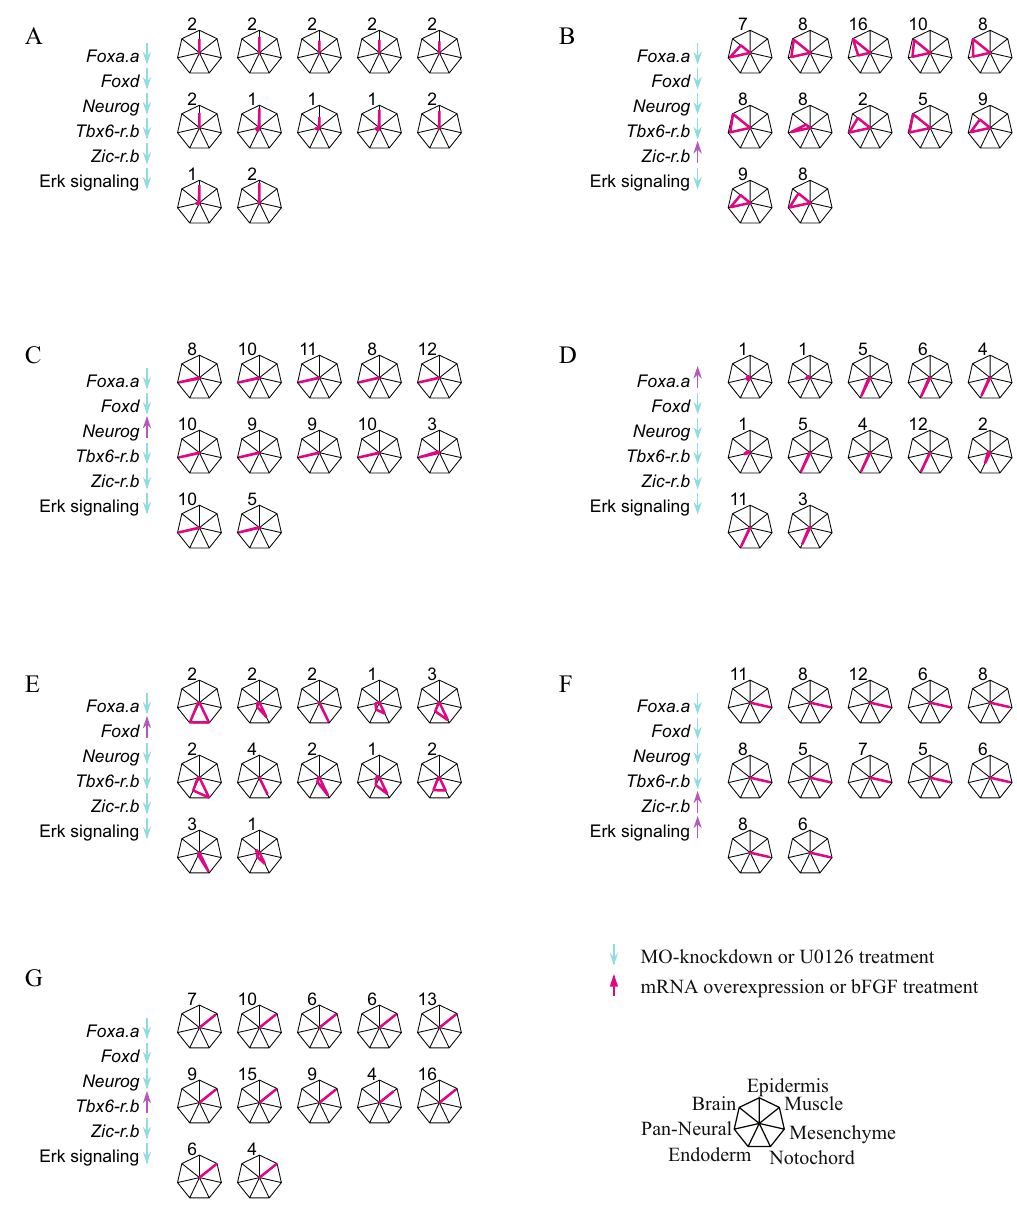
Figure 3. Gene expression in individual embryos in which cell fate is reprogrammed by manipulating activities of FVS factors in single-cell syncytium embryos. FVS factors are up- or down-regulated in seven different combinations as shown at the left of each panel. Radar graphs show expression levels of marker genes relative to their corresponding values in normal 9.5-h (tailbud) embryos. Each axis shows expression of a tissue marker, as shown at the bottom right. Values for twelve individual embryos, used for calculation of mean values in Fig. 2B, are shown in each condition. Note that brain cells express the brain and pan-neural